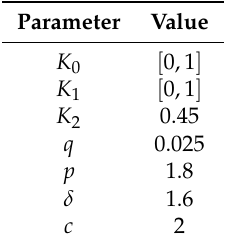
Table 4. Parameter values for the numerical